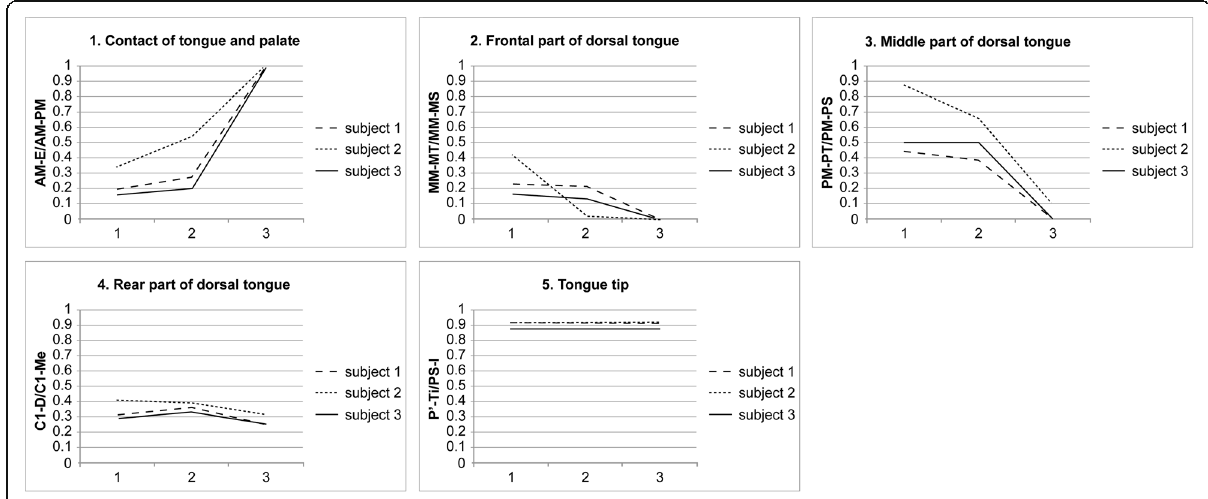
Fig. 9 Comparison of linear measurements between the three subjects. For abbreviations, see Table 1. Linear measurements are as per those described in Fig.